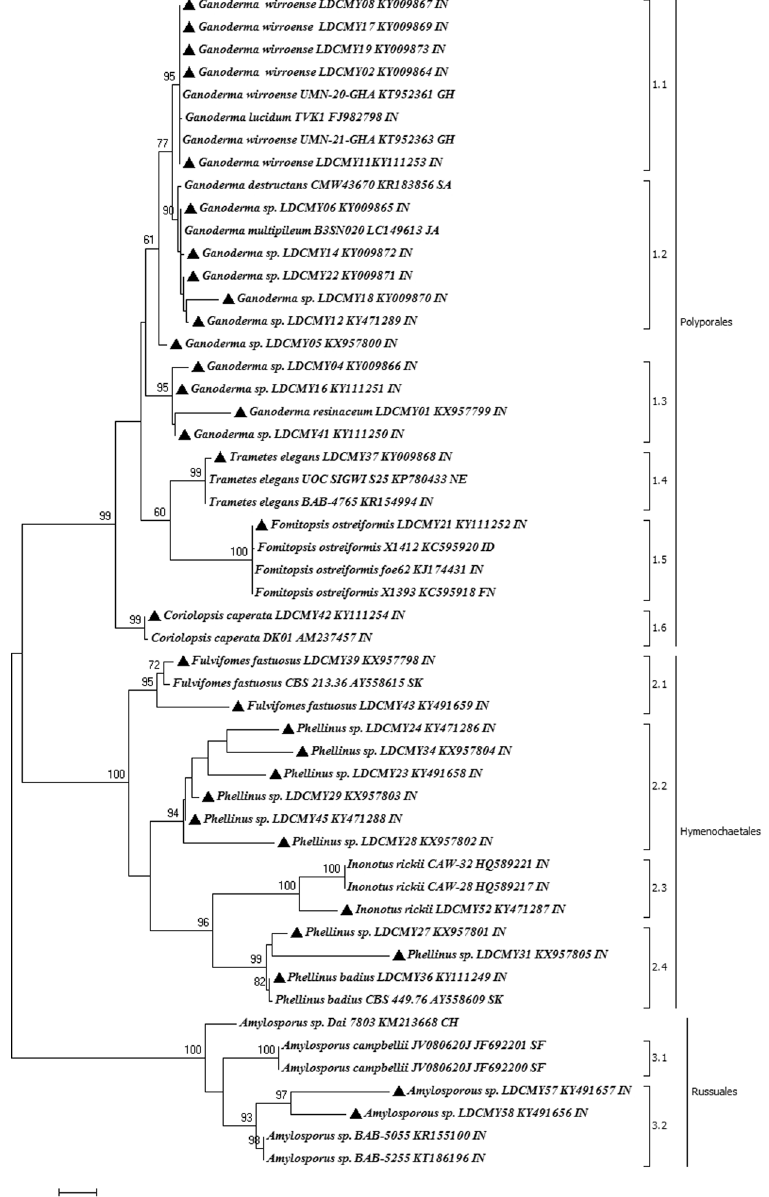
Figure 7. The evolutionary relationship was inferred using the maximum Likelihood method in MEGA6. The analysis involved 52 nucleotide sequences; thirty two sequences generated in this study are highlighted. The initial trees were obtained with the random addition of sequences. All positions containing gaps and missing data were eliminated. Numerical values above the internodes are the percentage of 1000 bootstrap replications. Bootstrap values higher than 60% are indicated. Scale bar 0.05 represents nucleotide substitutions per position. Three clades were predicted Clade 1: Polyporales; Clade 2: Hymenochaetales; Clade 3: Russuales. The abbreviated letters next to accession number indicates the localities from which the sample is collected: IN - India, GH - Ghana, CH- China, ID - Indonesia, FL - Finland, NE - Nepal, SA - South Africa, SF - South Florida, SK - South Korea, SL - Sri Lanka. The diversity within subpopulation was predicted as 0.1, the diversity within entire population - 0.3 with a Mean inter population Diversity - 0.3 and Coefficient of differentiation -